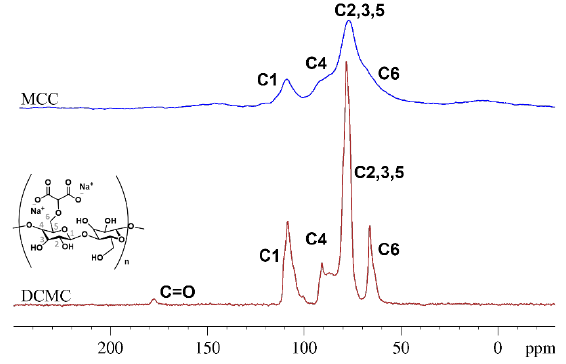
Figure 3. 13 C CP-TOSS NMR spectra of MCC and DCMC.